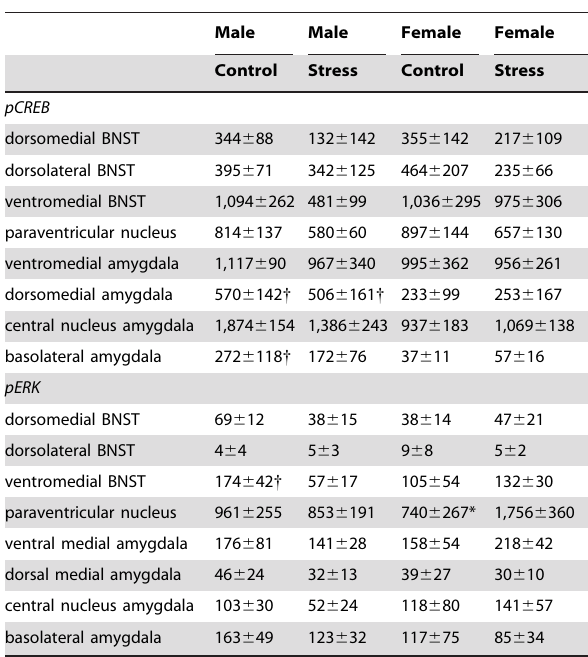
Table 2. Cell counts for pCREB and pERK positive cells immediately after social interaction